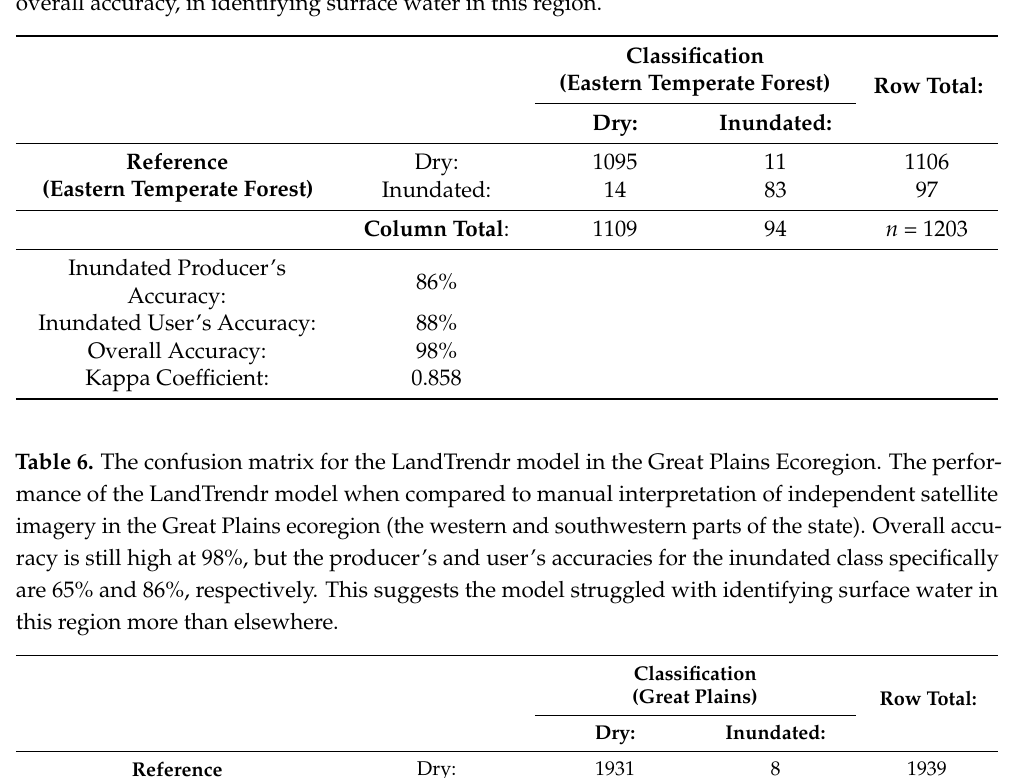
Table 5. The confusion matrix for the LandTrendr model in the Eastern Temperate Forest Ecoregion. The performance of the LandTrendr model when compared to manual interpretation of independent satellite imagery in the Eastern Temperate Forest ecoregion (central and southeastern parts of the state). Overall accuracy is high at 98%, producer’s and user’s accuracies for the inundated class are 86% and 88%, respectively. This suggests good performance of the LandTrendr model, similar to the overall accuracy, in identifying surface water in this region.